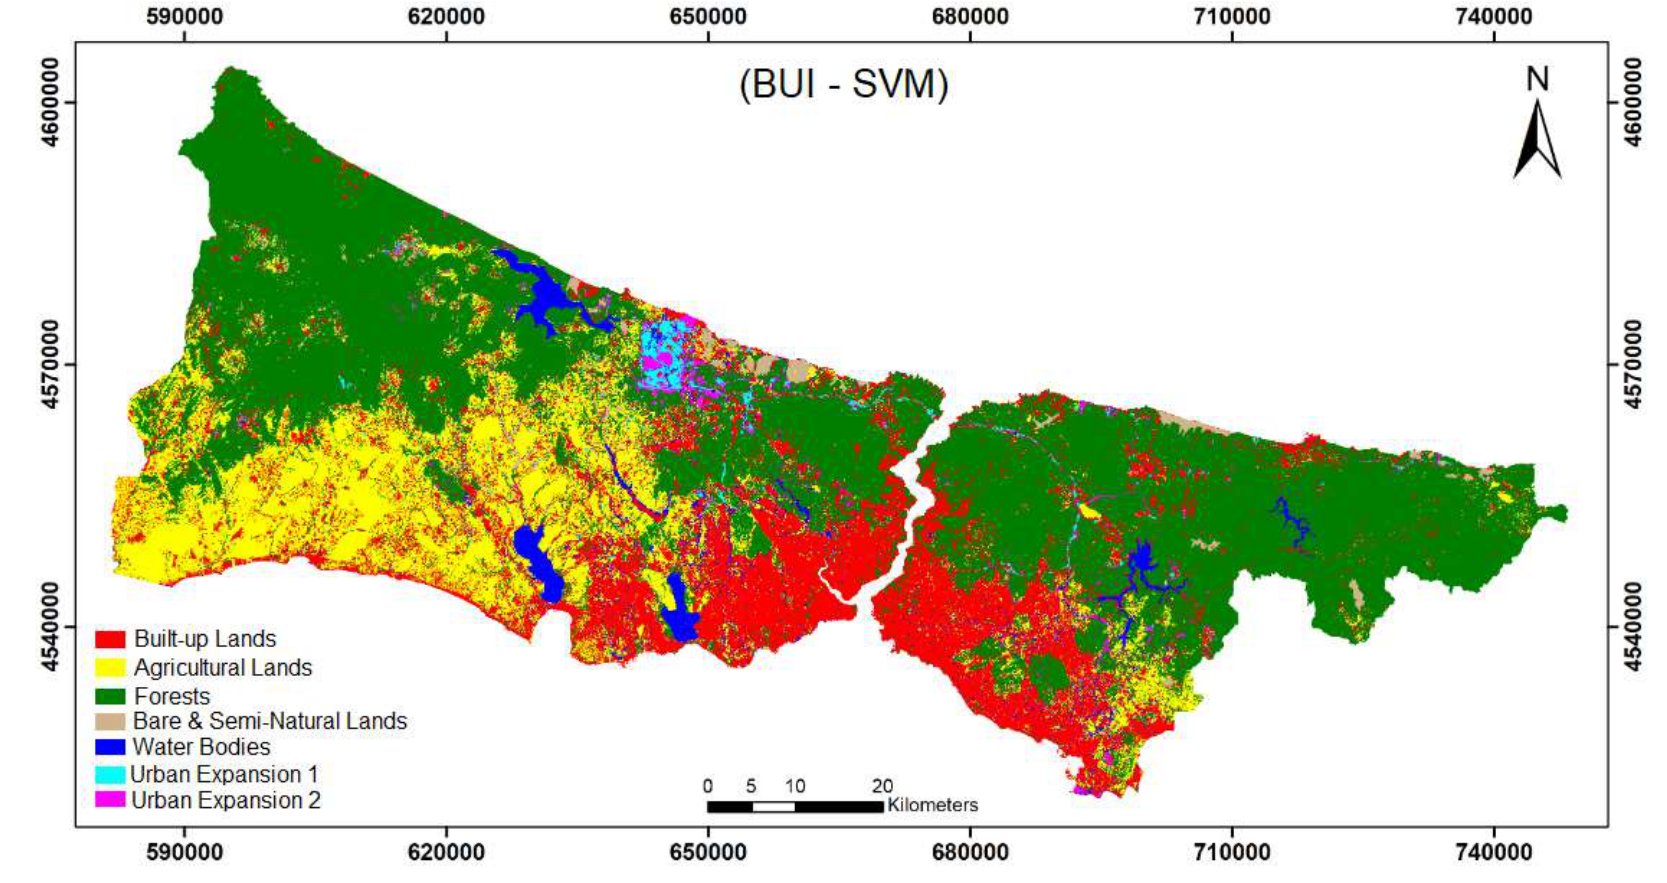
Figure A5. SVM classification results of the BUI dataset.